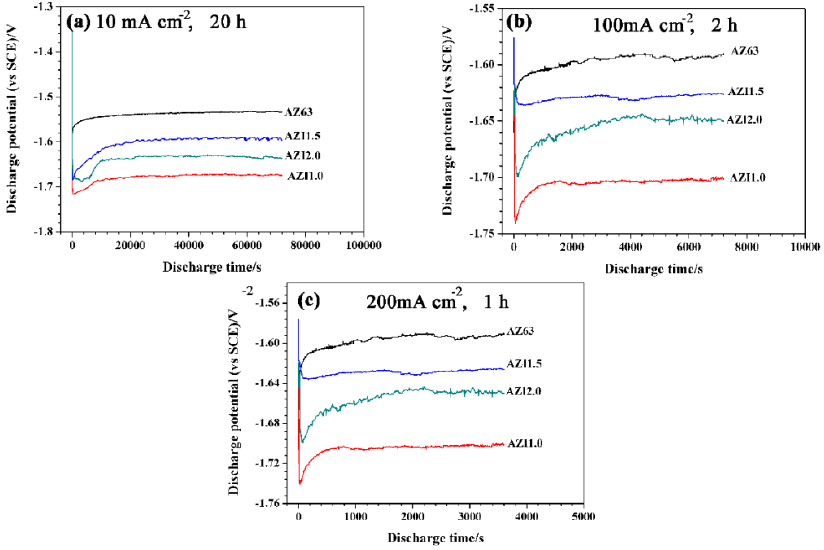
Figure 9. Potential‐time curves of AZ63 and AZI alloys at different anodic current densities in 3.5 wt% NaCl at 25 ± 1 C, 10 mA·cm −2 20 h ( a ), 100 mA·cm −2 2 h ( b ) and 200 mA·cm −2 1 h ( c ).